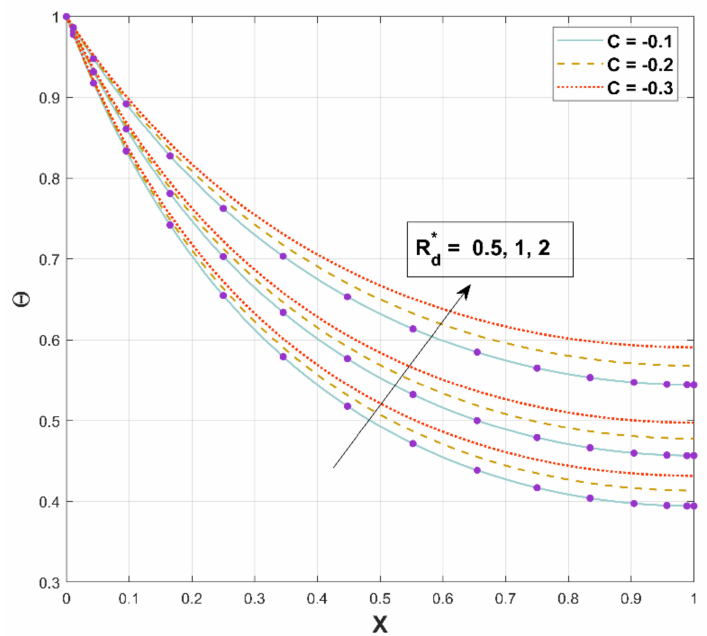
Figure 8. Upshot of R ∗ on Θ . d Surface convective heat transmission is involved in the rate of heat transmission and is indicated by the parameter Nc , which has the correlation between the convective and conductive processes. The influence of this parameter on the thermal field is indicated in Figure 9. According to this figure, improving this ratio lowers the temperature distribution. As the convection effect improves, more heat from the fin surface is transferred to the surroundings. The temperature consequently drops as the rate of heat transfer